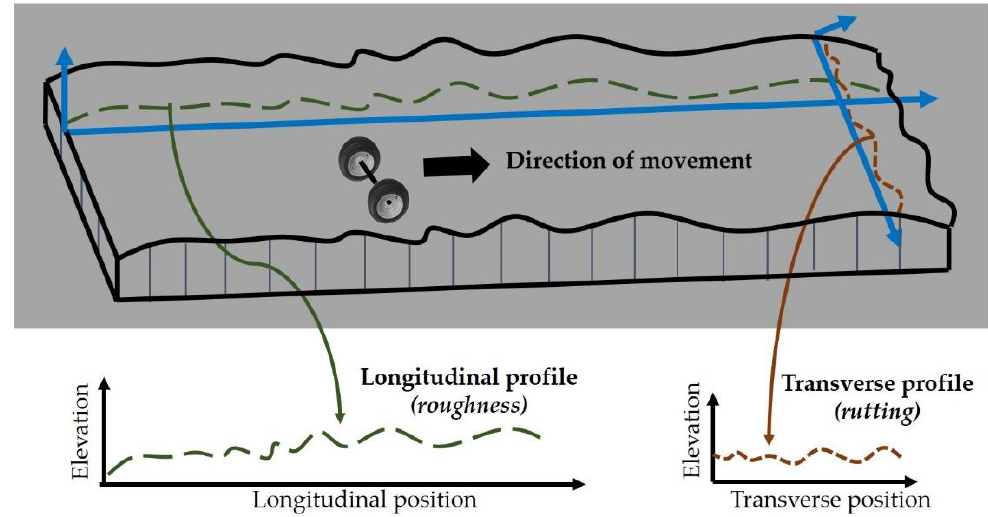
Figure 1. Schematic illustration of pavement profile components (adapted from [33], copyright 2018, Fast track publications).